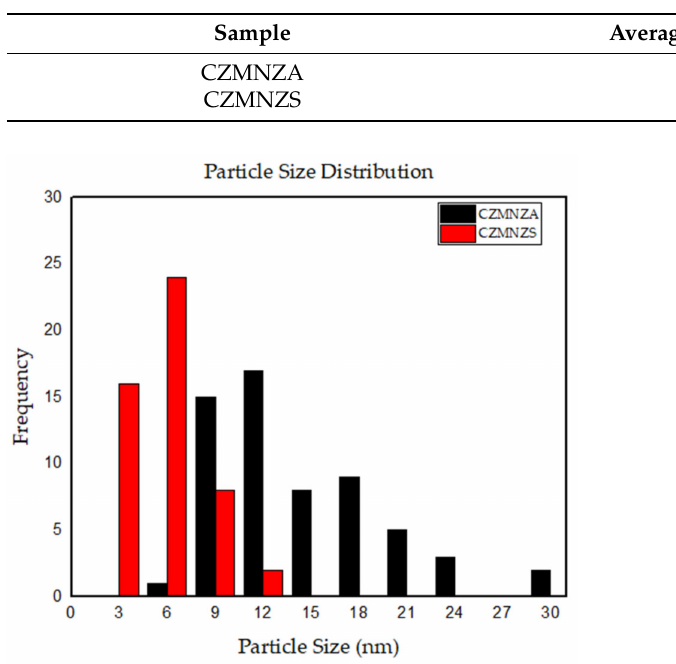
Figure 5. TEM images of ( a ) CZMNZA ( b ) CZMNZS. Table 2. Average particle size of catalysts.